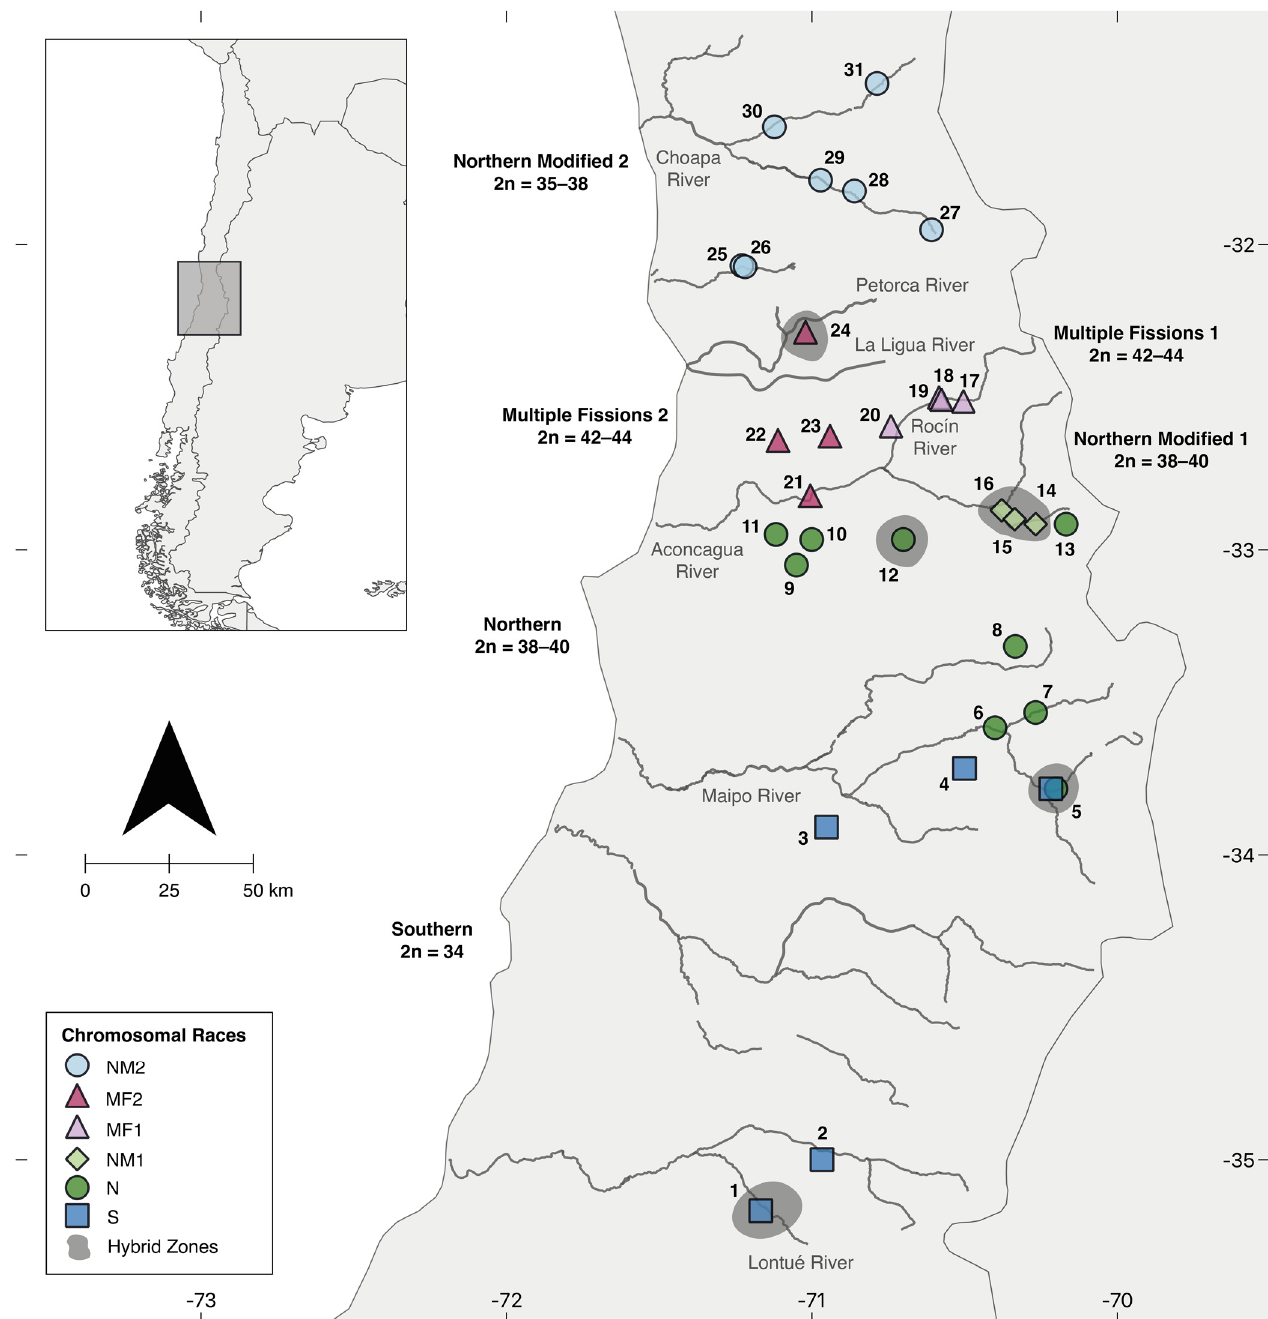
Figure 1. Distribution map of locality samples for six L. monticola chromosomal races. Detected potential hybridization zones are shaded. Data include new sampling as well as previously described chromosome races.